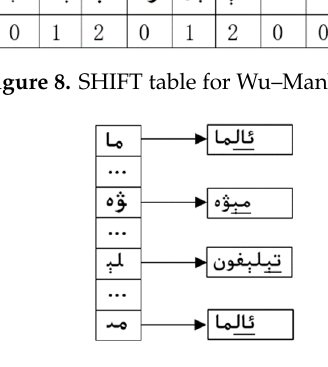
Figure 9. HASH table for Wu–Manber–Uy.